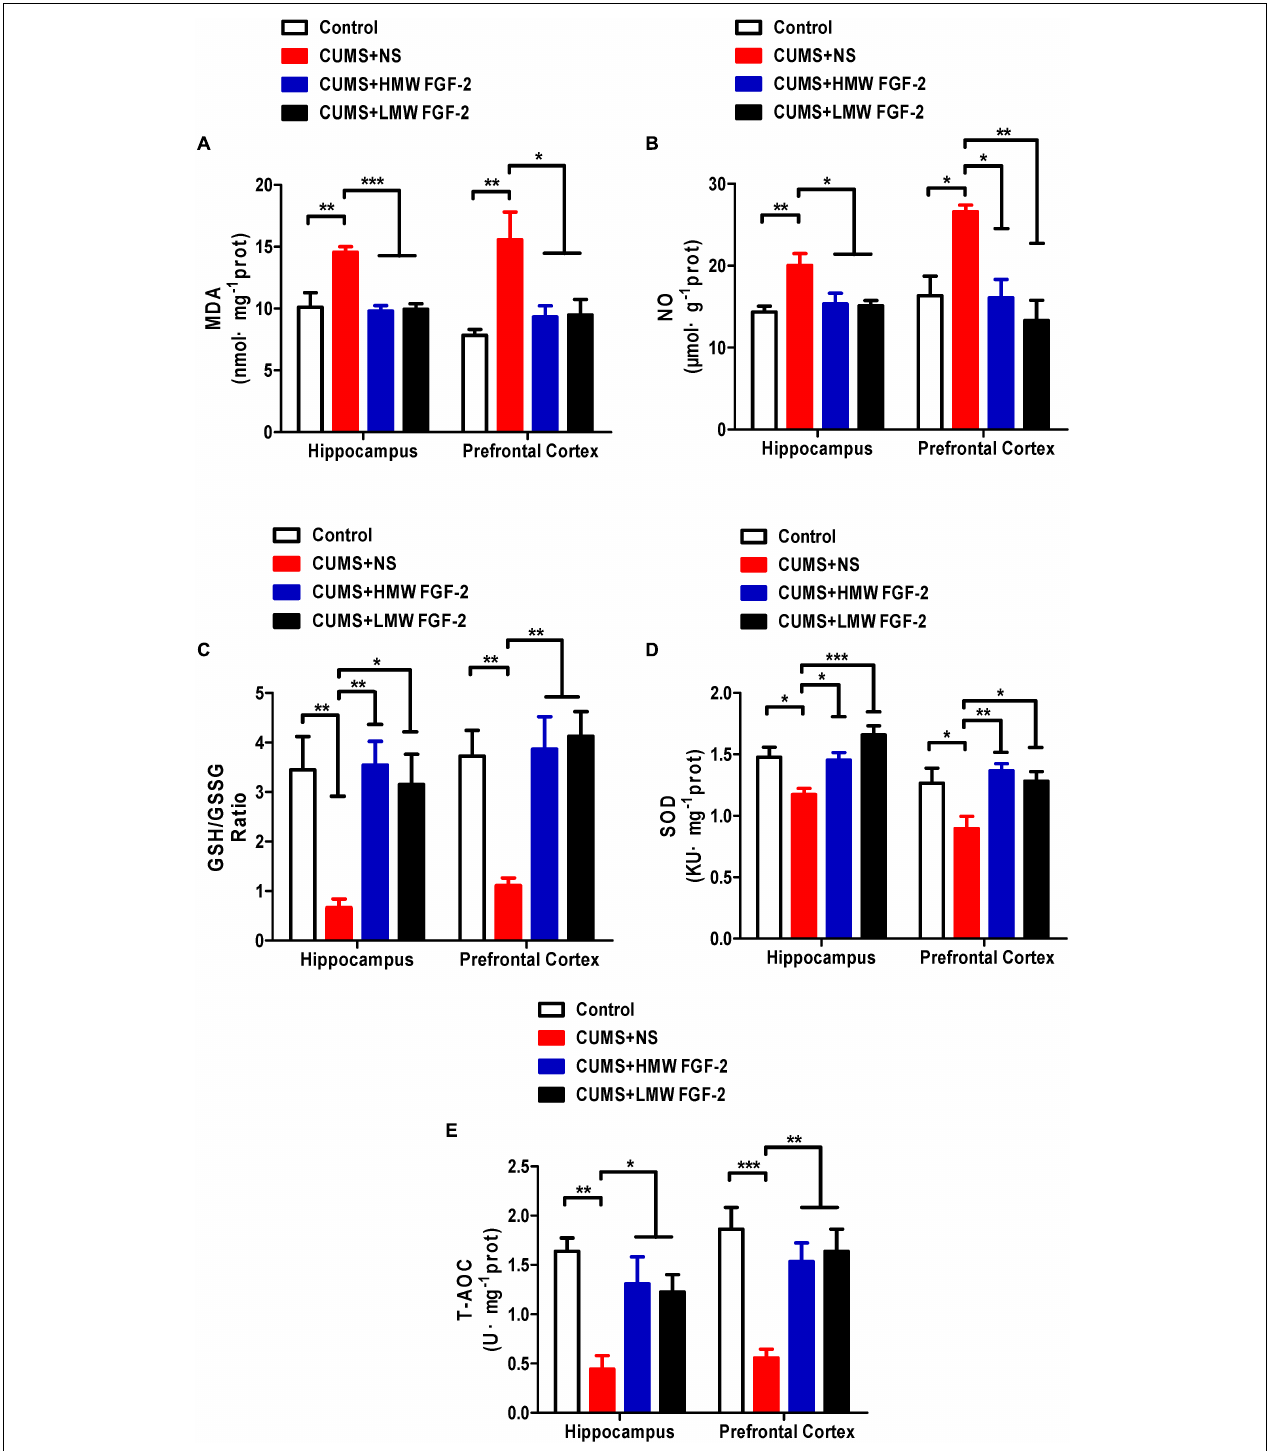
FIGURE 3 | Effects of FGF-2 on the changes in five oxidative stress indices, MDA, NO, GSH, SOD and T-AOC, in the hippocampus and prefrontal cortex of CUMS-induced mice. (A) MDA content. (B) NO content. (C) GSH/GSSG ratio. (D) SOD activity. (E) T-AOC activity. Data are expressed as the mean ± SEM. Compared with those in the control group, MDA and NO levels were significantly increased, while SOD and T-AOC activity, as well as the GSH/GSSG ratio, were significantly decreased in the hippocampus and prefrontal cortex of CUMS mice. Furthermore, compared with those in the CUMS+NS group, MDA and NO levels were significantly decreased, while SOD and T-AOC activity, as well as the GSH/GSSG ratio, were significantly increased in the FGF-2-treated groups. (A–E) , one-way ANOVA with Tukey’s post hoc test, n = 6, ∗ p < 0.05, ∗∗ p < 0.01, and ∗∗∗ p < 0.001.